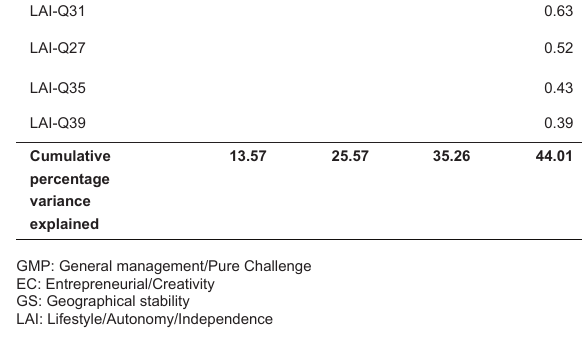
TABLE 1 EFA rotated factor matrix: Principal axis factoring with varimax rotation section 1-importance